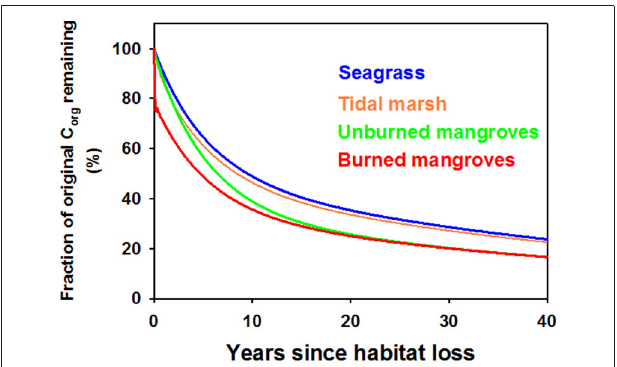
FIGURE 3 | Model output of the fraction of the original organic carbon remaining in Blue Carbon ecosystems in the 40 years following disturbance, assuming that half of the organic carbon gets deposited in an oxic environment following disturbance (i.e., α = 0.5). Seagrasses in blue, tidal marshes in orange, mangroves where all above-ground biomass was burned (red) or the aboveground biomass was left to decompose in situ (green).